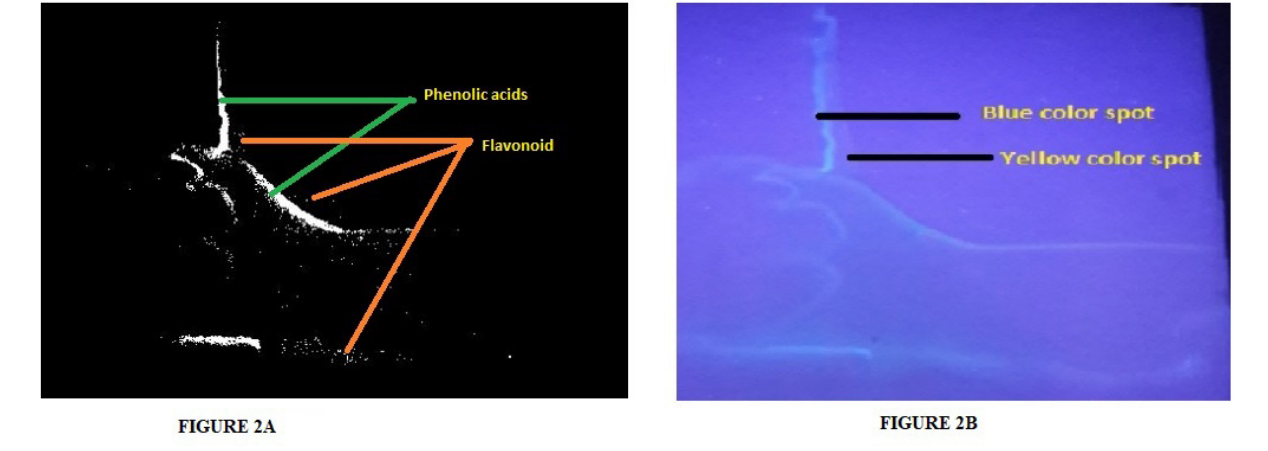
FIGURE 2 - Digital image segmentation (OTSU method) analysis of PTLC plates: (A): Image segmented view (Gray scale); (B) : Original PTLC plate